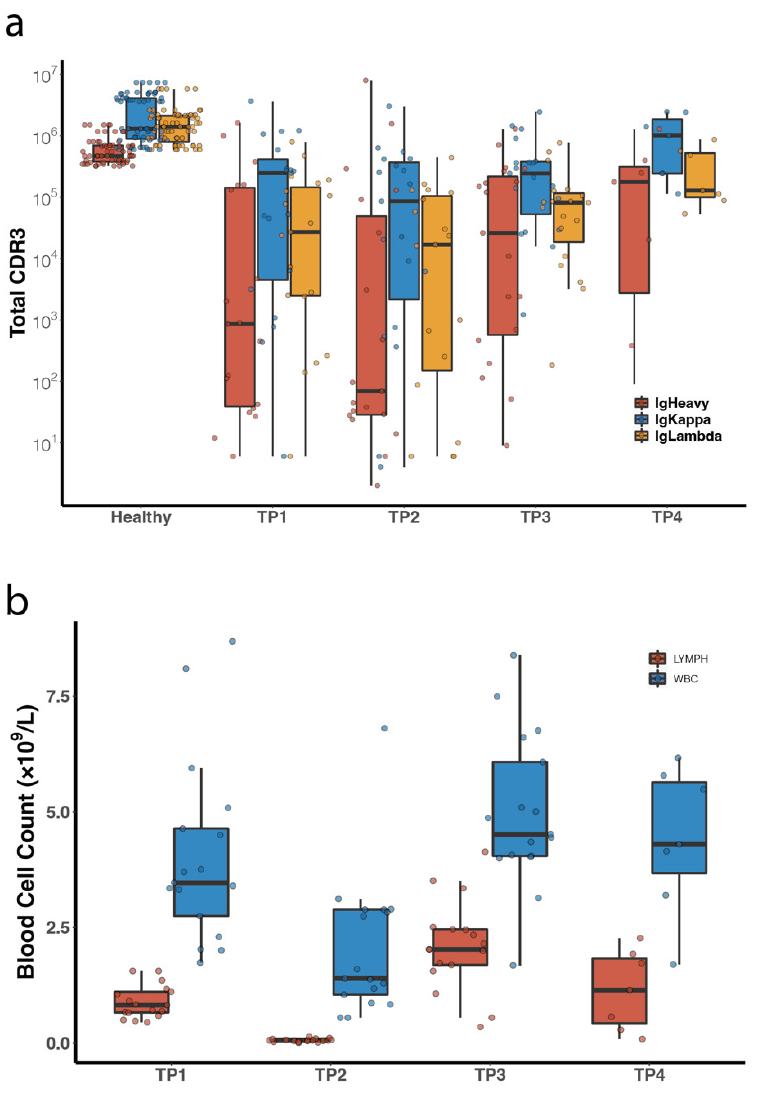
Figure 4. Population measures of the patients’ peripheral blood samples. ( a ) Total CDR3 reads from blood samples of healthy volunteers and DLBCL patients. ( b ) Populations of lymphocytes (LYMPH) and white blood cells (WBC) in patients-derived samples.